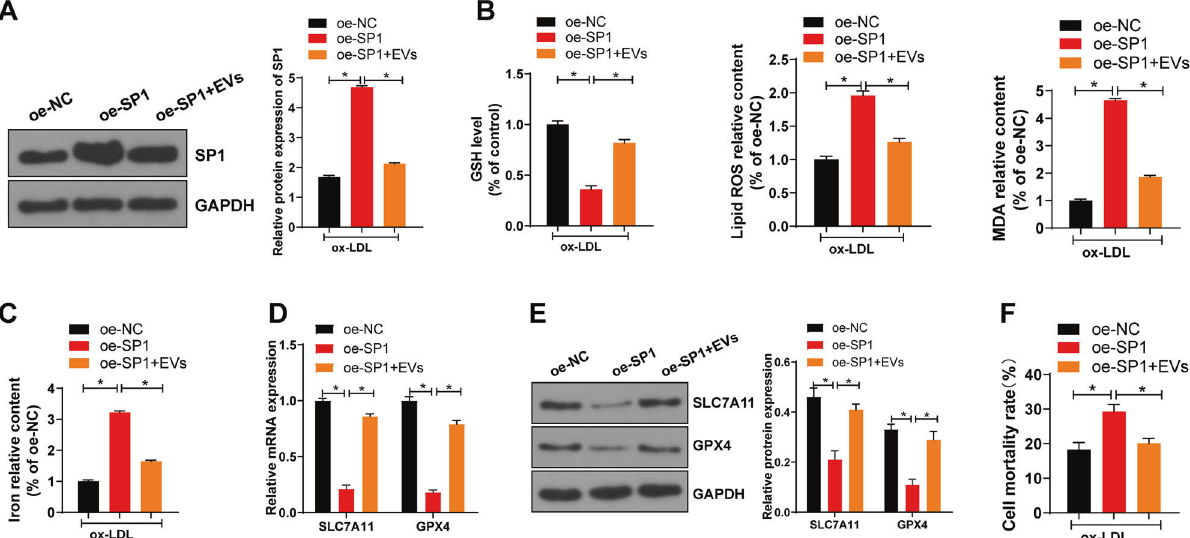
Fig. 5 EV-miR-199a-3p targeted SP1 and thereby inhibited ferroptosis of ECs. A SP1 expression in each group was detected using western blot. B GSH consumption, lipid ROS production, and lipid peroxidation were detected using the kits. C The relative content of iron in MAECs was determined using the commercial kit. D , E SLC7A11 and GPX4 mRNA expression and protein levels in MAECs were detected. F Cell death rate was detected by trypan blue staining. Each experiment was repeated three times independently. Measurement data are depicted as mean ± SD. The t test was used for the comparisons between two groups. One-way ANOVA was employed for the comparisons among multiple groups, followed by Tukey ’ s multiple comparisons test. * p <